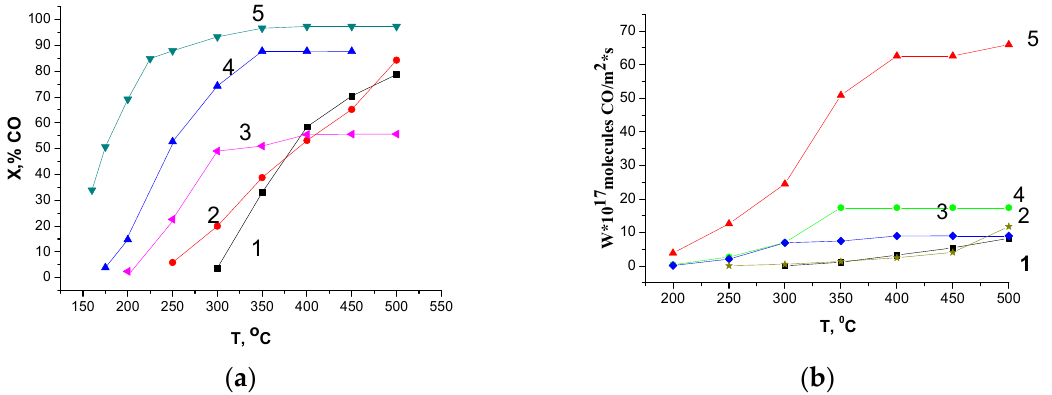
Figure 6. Conversion of CO ( a ) and rate of CO oxidation ( b ) for the as-prepared samples. The gas mixture (1% СО + 1% О 2 + 98% N 2 ) flow rate is 10 l/h; circulation 900–1000 l/h, and contact time (τ) is 0.2 s. Curves designations correspond to sample numbers (Table 1).